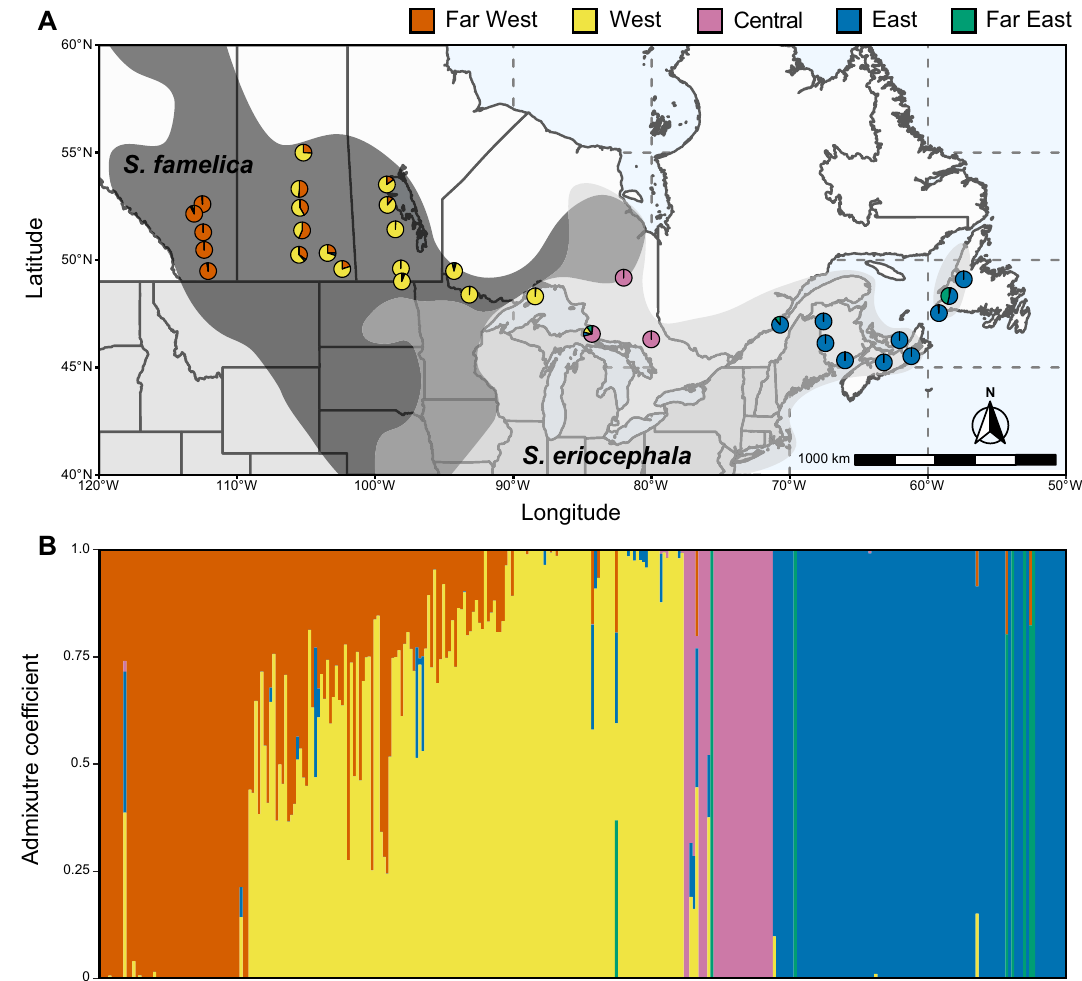
324 genotypes of Salix famelica and Salix eriocephala sorted from west to east for K = 5 Figure 2. Inference of population structure based on 26,016 polymorphisms in 324 genotypes of S. famelica and S. eriocephala from 33 sites of origin using Bayesian simulations. ( A ) Pies show mean admixture results ( K = 5) across genotypes for each site of origin. Shaded areas indicate the species distributions reported in Argus 39 . Map generated using R packages ggplot2 42 , scatterpie 43 , rnaturalearth 44 , and ggspatial 45 . ( B ) Distribution of fastSTRU CTU RE-defined clusters among 324 genotypes, sorted from west to east, for K = 5 where the y-axis indicates the estimated admixture coefficients for each